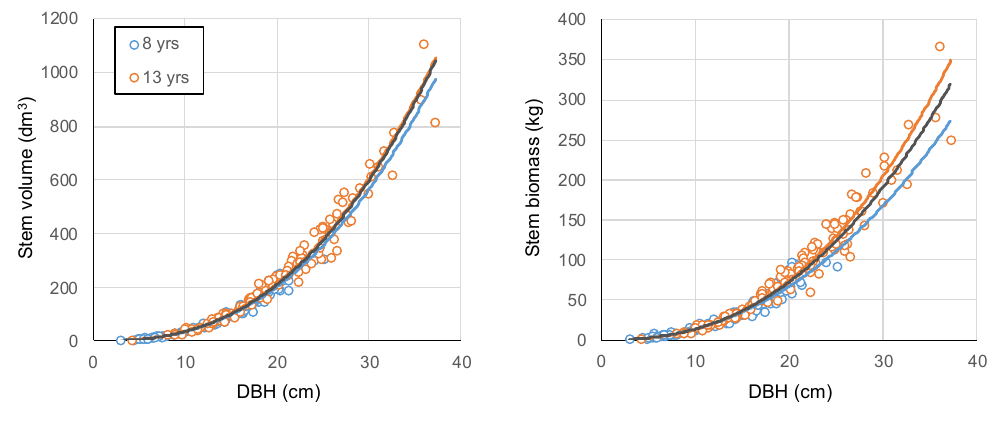
Figure 2. General (5 clones combined) allometric relationships between diameter at breast height (cm) and stem volume (dm 3 ), and stem dry biomass (kg) in poplar plantations. The black line indicates the general model developed combining the 8 and 13 year data obtained from trees harvested in the poplar